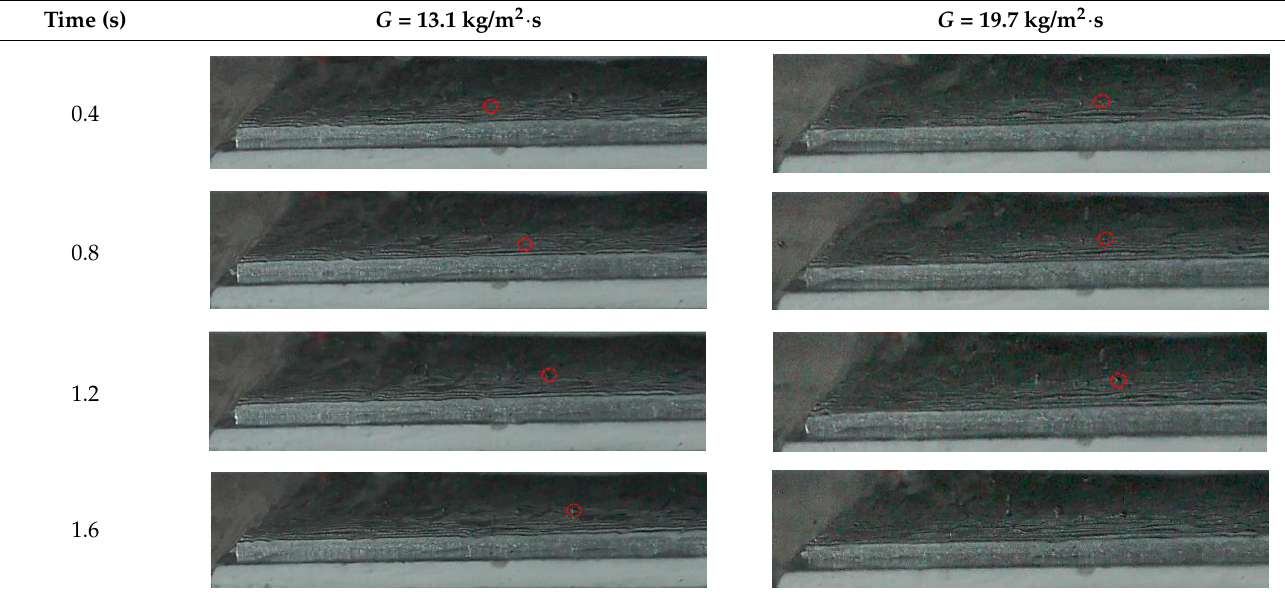
Figure 8. Pressure drops among four different surfaces.